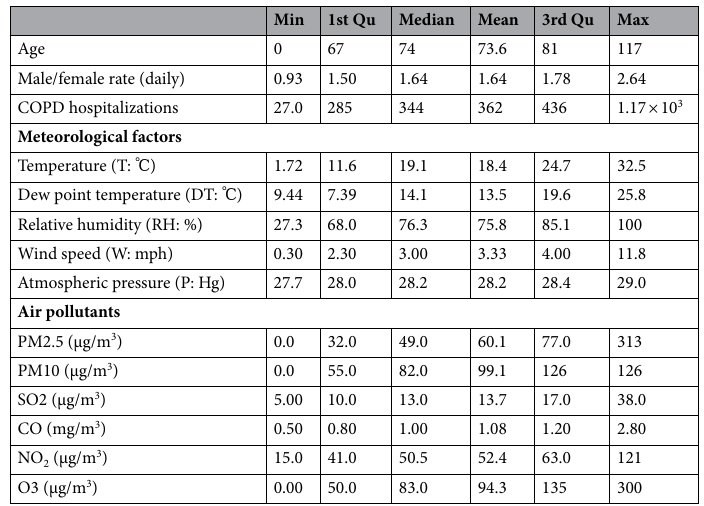
Table 1. Descriptive statistics of COPD patient age, sex rate, daily hospitalizations, meteorological factors and air pollutants in Chengdu, China during Jan/2015–Dec/2017. Min, Qu and Max mean minimum, quartile and maximum of the variables, respectively.